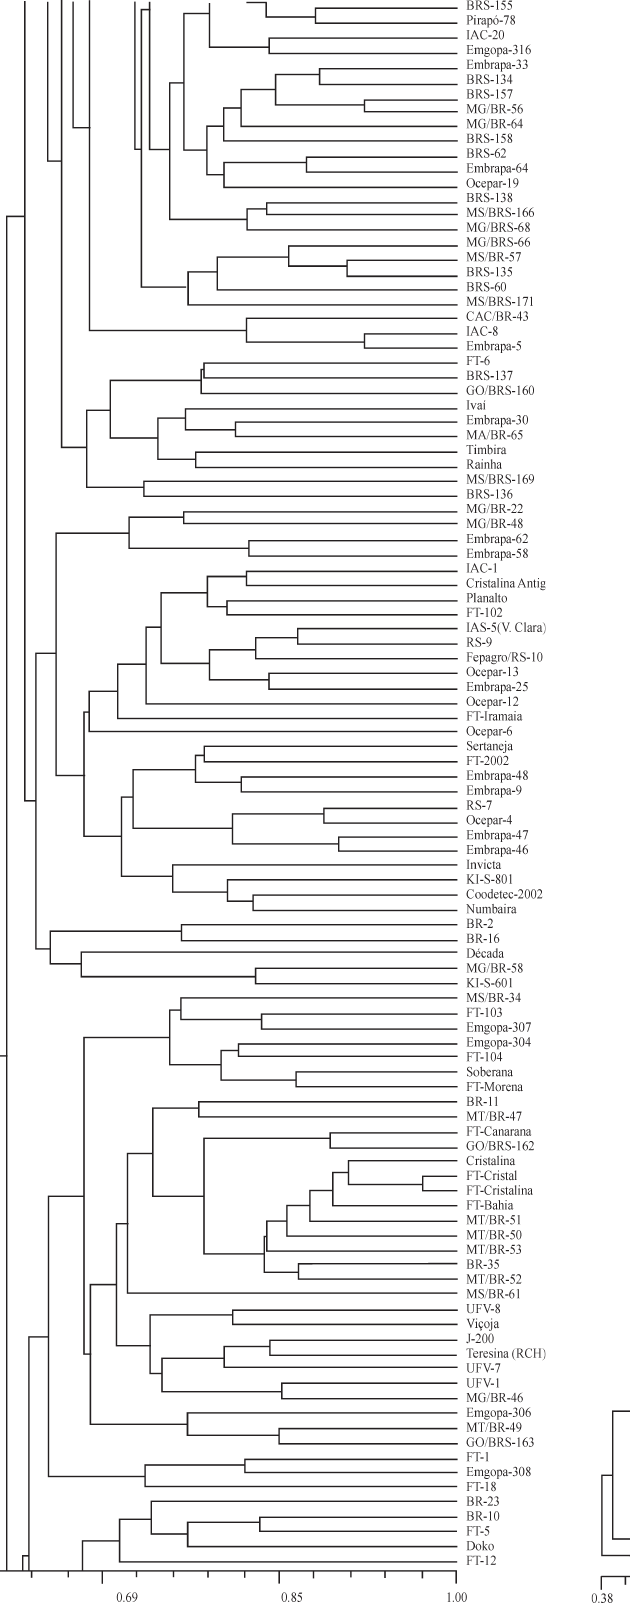
Figure 4b - UPGMA dendrogram based on AFLP similarity coefficients of 317 soybean cultivars (cont.)